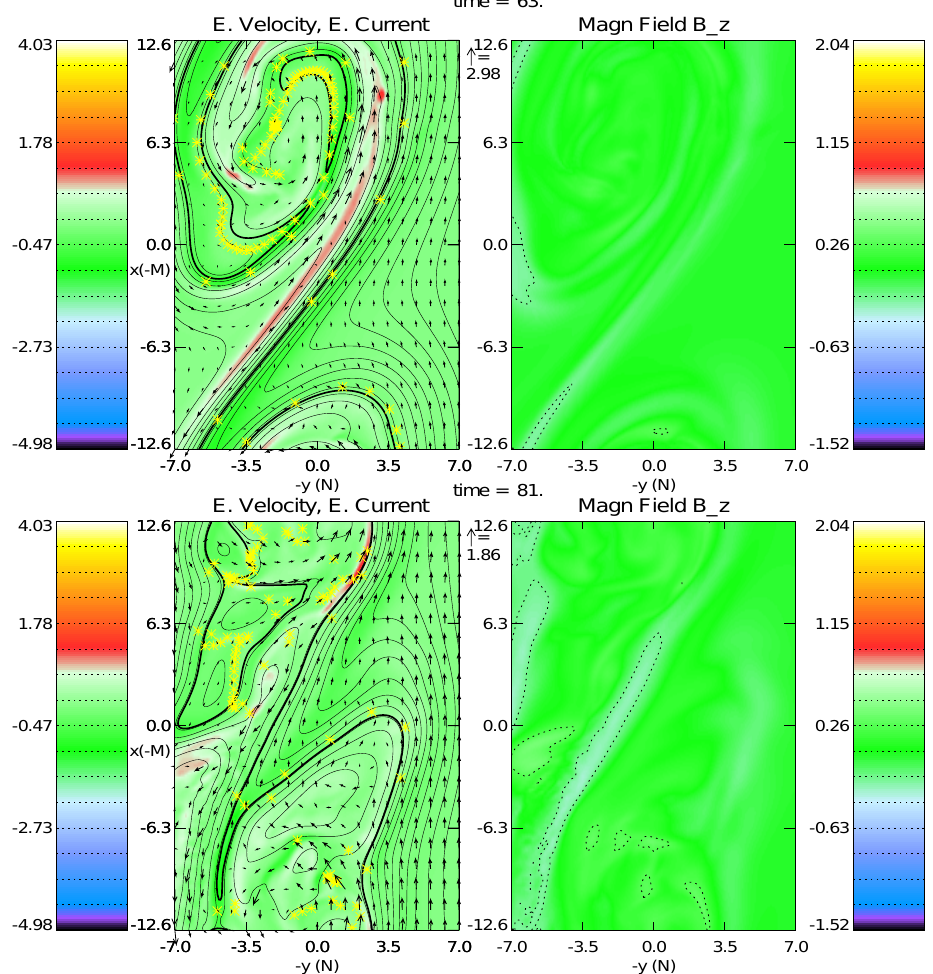
Fig. 4. KH vortex at t/τ A ≈ 63 and at t/τ A ≈ 81. Lines are magnetic field lines projected to x,y -plane and arrows are electron velocity vectors. Color code represents electron current (left) and z component of the magnetic field